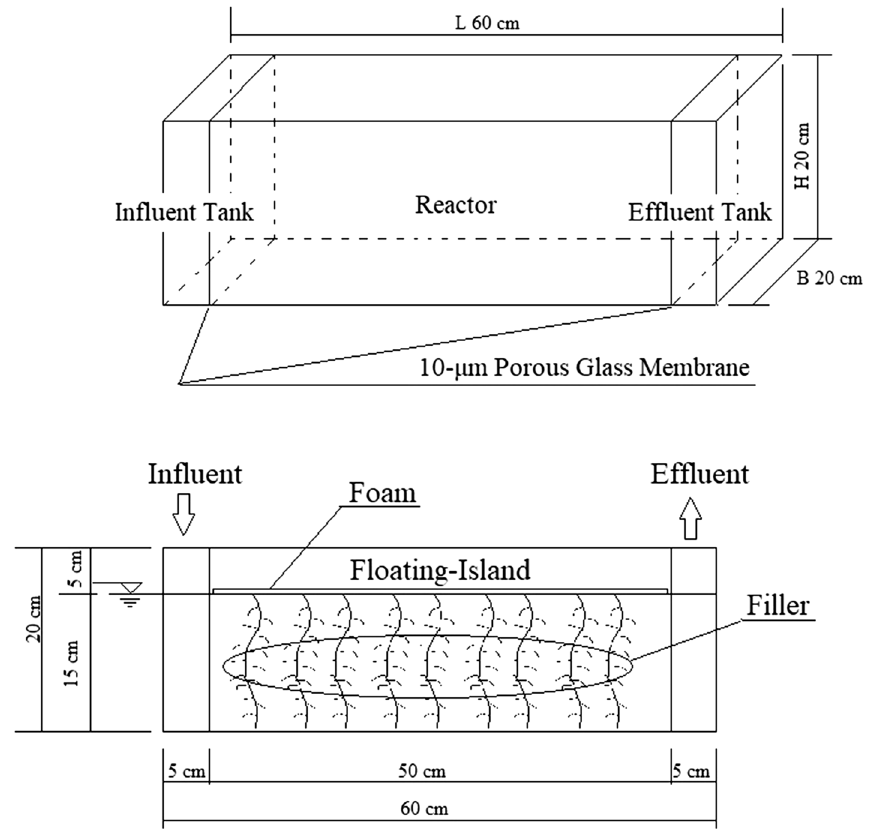
Fig. 1 Experimental device of the transport behaviors of naph‑ thalene by different